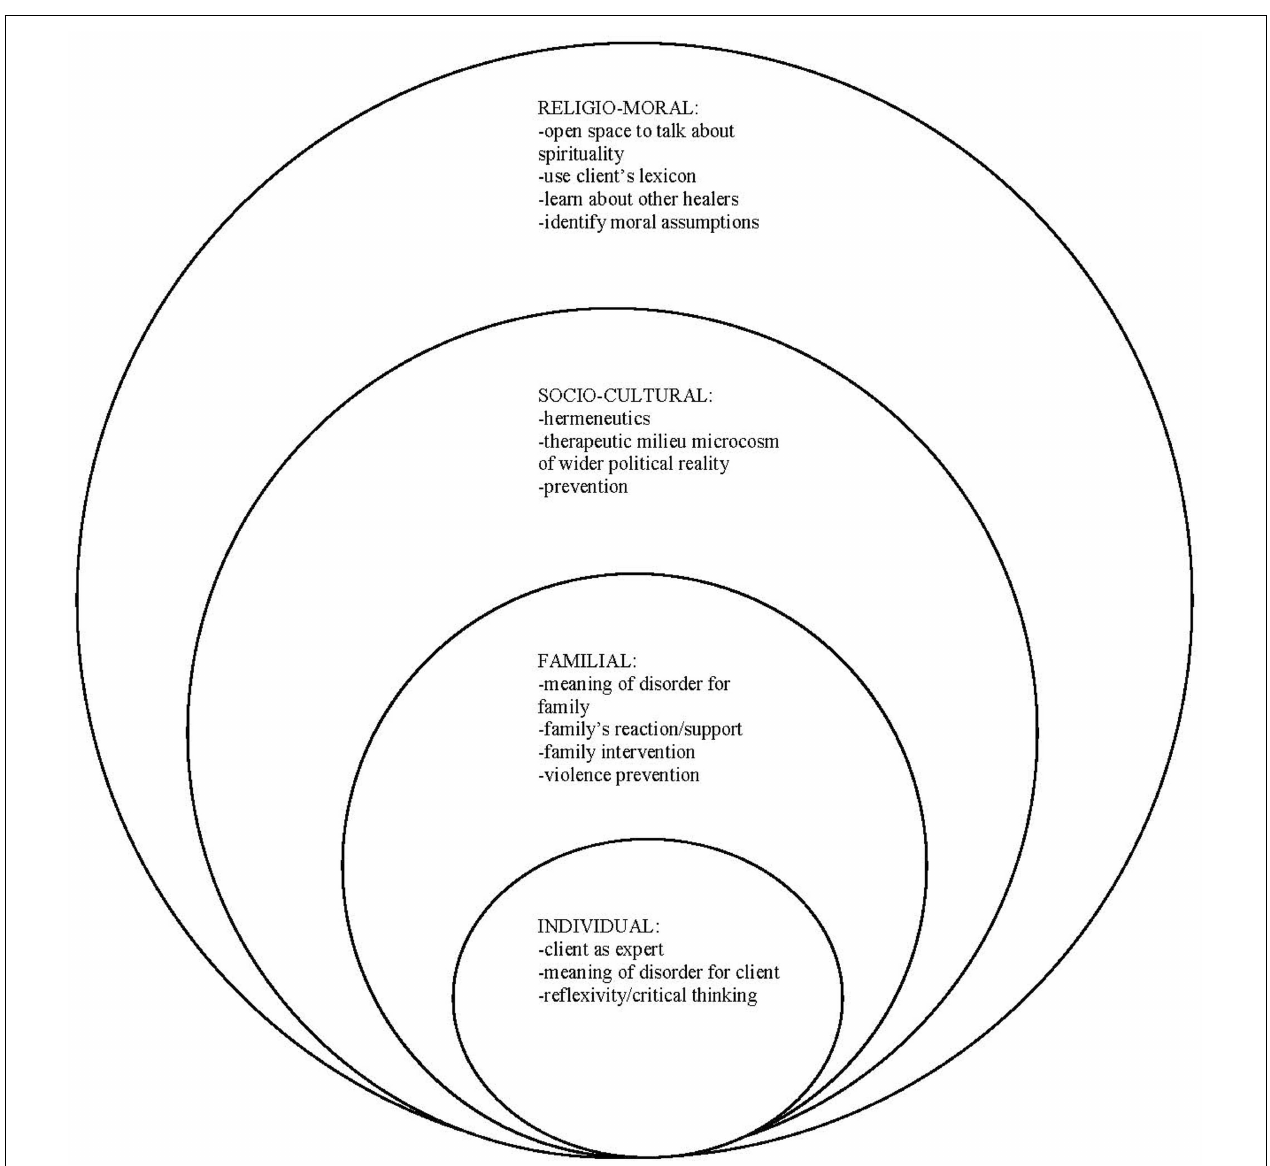
FIGURE 1 |A multidimensional model of cultural psychotherapy and counseling with Portuguese